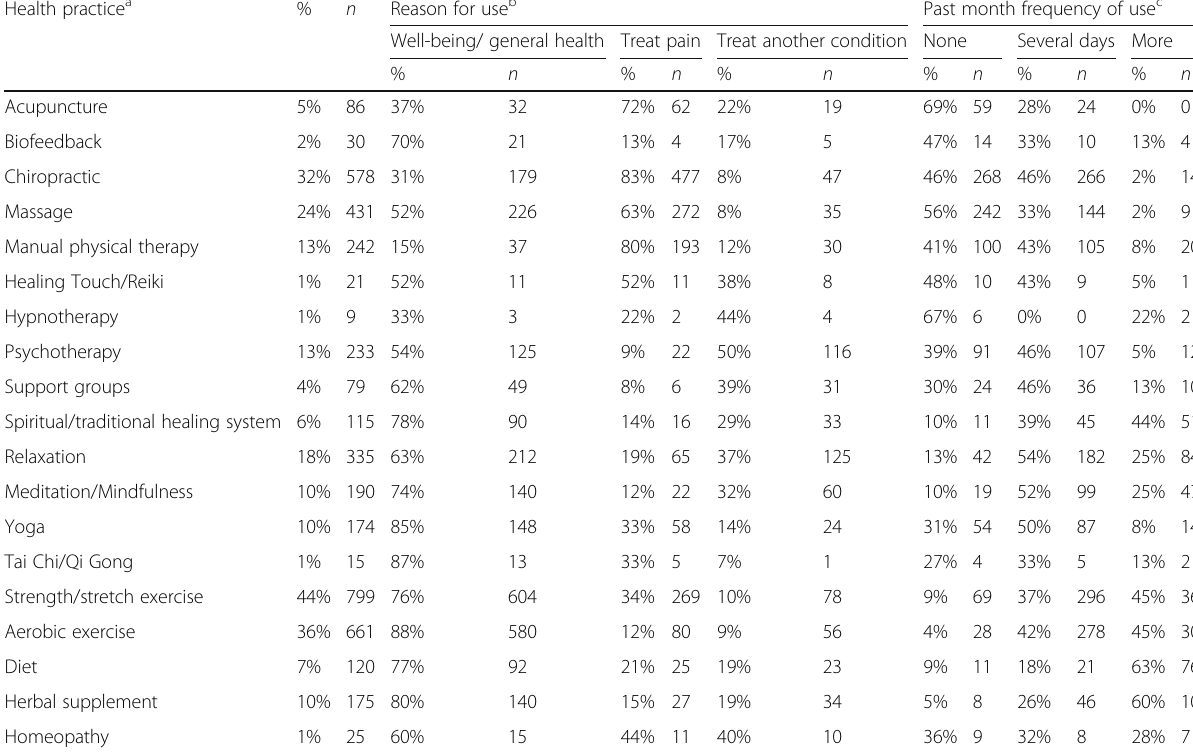
participated in the mailed survey conducted from October 2015 to September